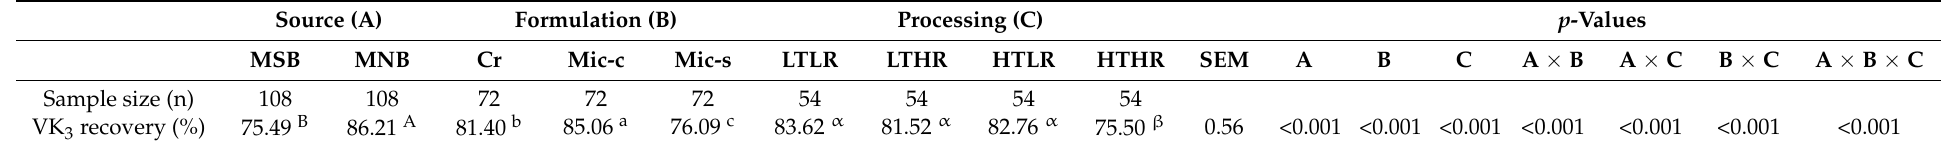
Table 2. Effects of sources and formulations of vitamin K 3 and pelleting parameter on its